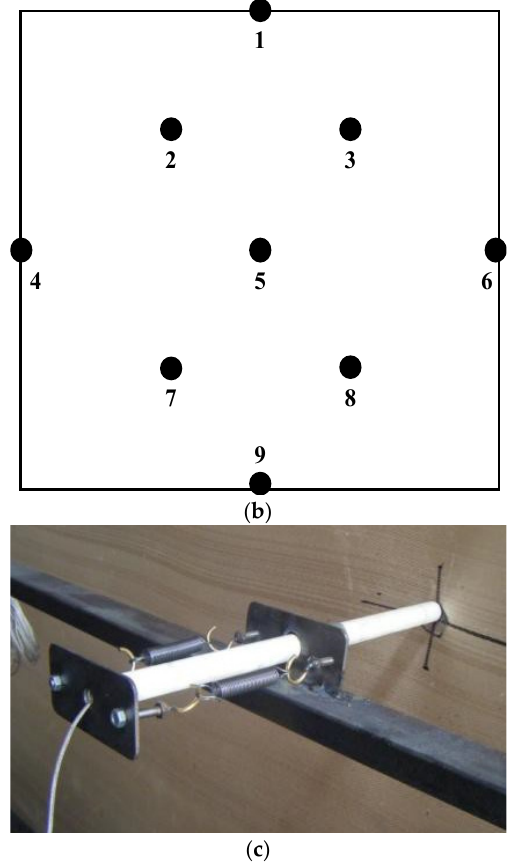
Figure 2. Thermocouples on the unexposed surface of the curtain: ( a ) installed on the testing frame, ( b ) positions of the thermocouples, ( c ) fixed with a spring device.